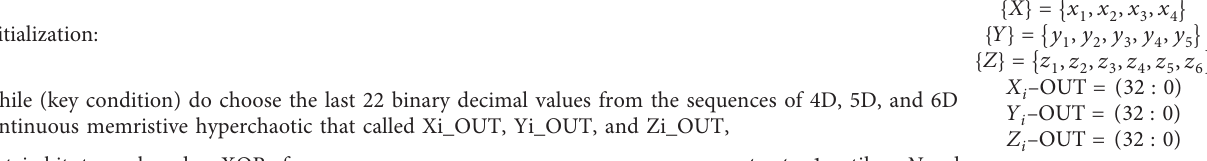
Table 1: Flow chart of the specific process of the PRNG design.